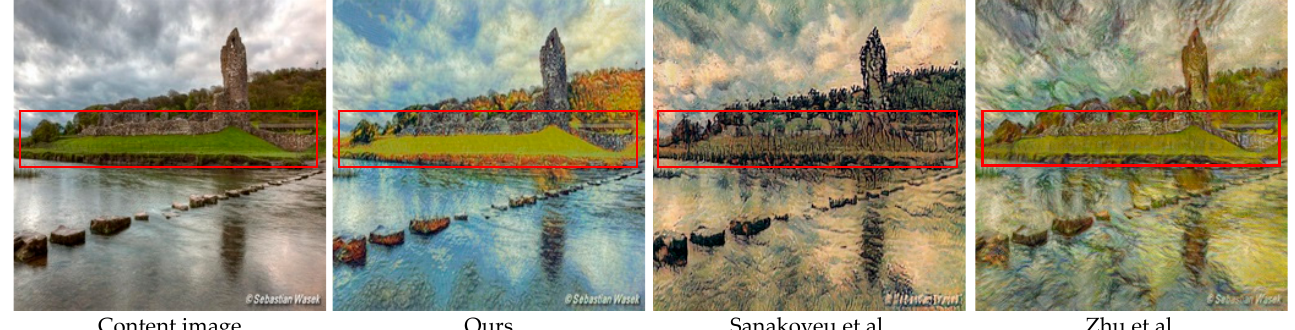
Figure 1. Comparison with Sanakoyeu et al. [12] and Zhu et al. [13] from Van Gogh’s style. These methods implement style transfer based on a collection of style images. The red frame shows that the effectiveness of jointly training IFFM content loss and style loss, and our method can achieve style transfer based on semantic information.